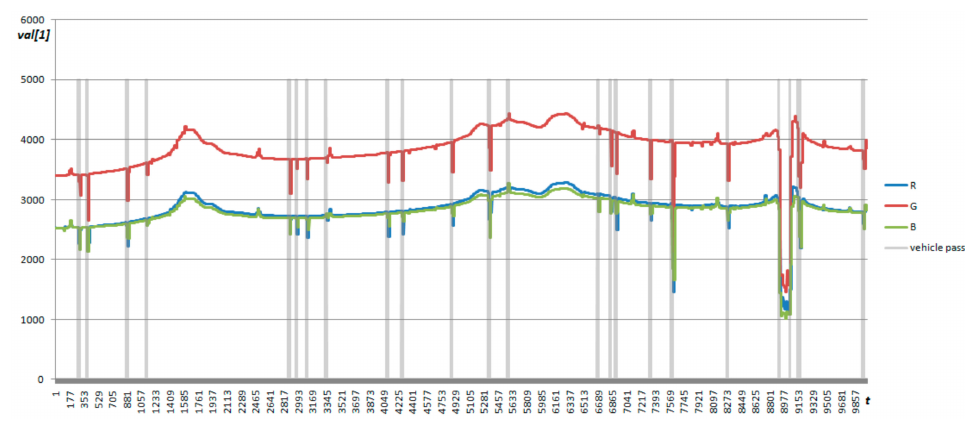
Figure 10. Readings of light sensor. Table 8. Accuracy of object detection based on individual sensors in